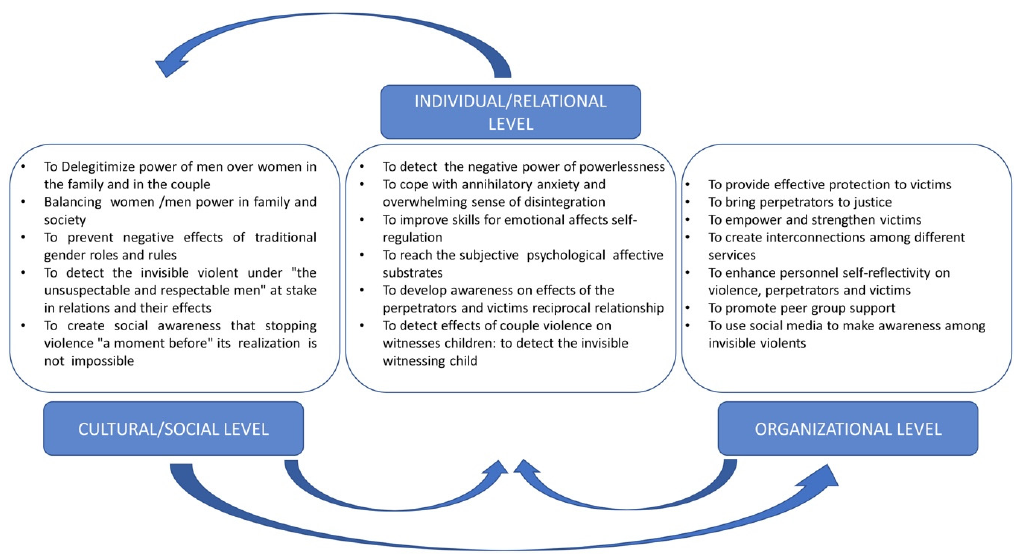
Figure 1. The ecological model and operationalization of goals and actions at different levels. Source: Di Napoli et al., 2019 [10].